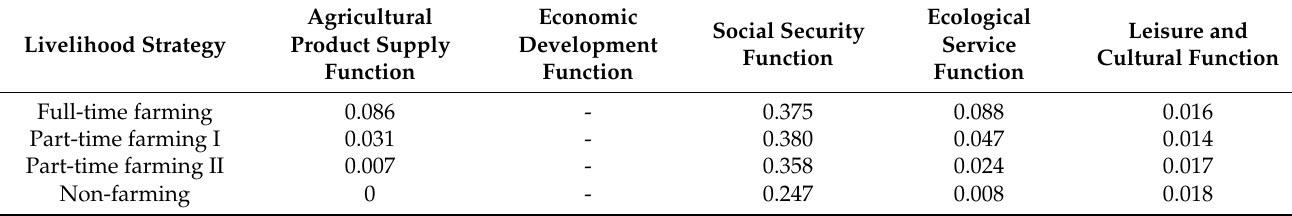
Table 6. Differences in the agricultural functions of households with different livelihood